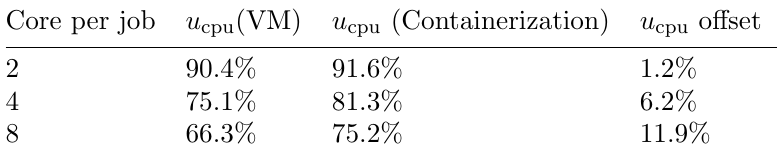
Table 3. BOINC job CPU efficiency: VM vs. Containerization